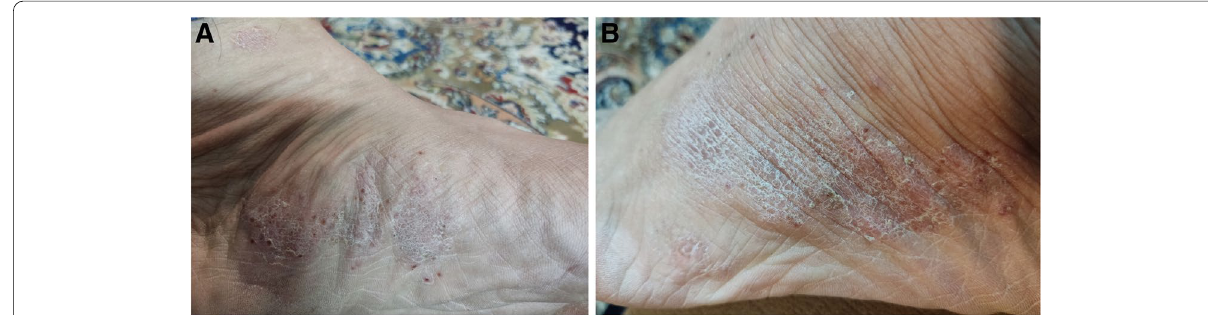
Fig. 4 Palmoplantar pustular psoriasis. Scaly plaque with punctuated appearance on the plantar ( A ) and dorsolateral surface of left foot suggestive of palmoplantar pustular psoriasis ( B ). Images 4 A and B were obtained via Xiaomi Poco X3 Pro cellphone